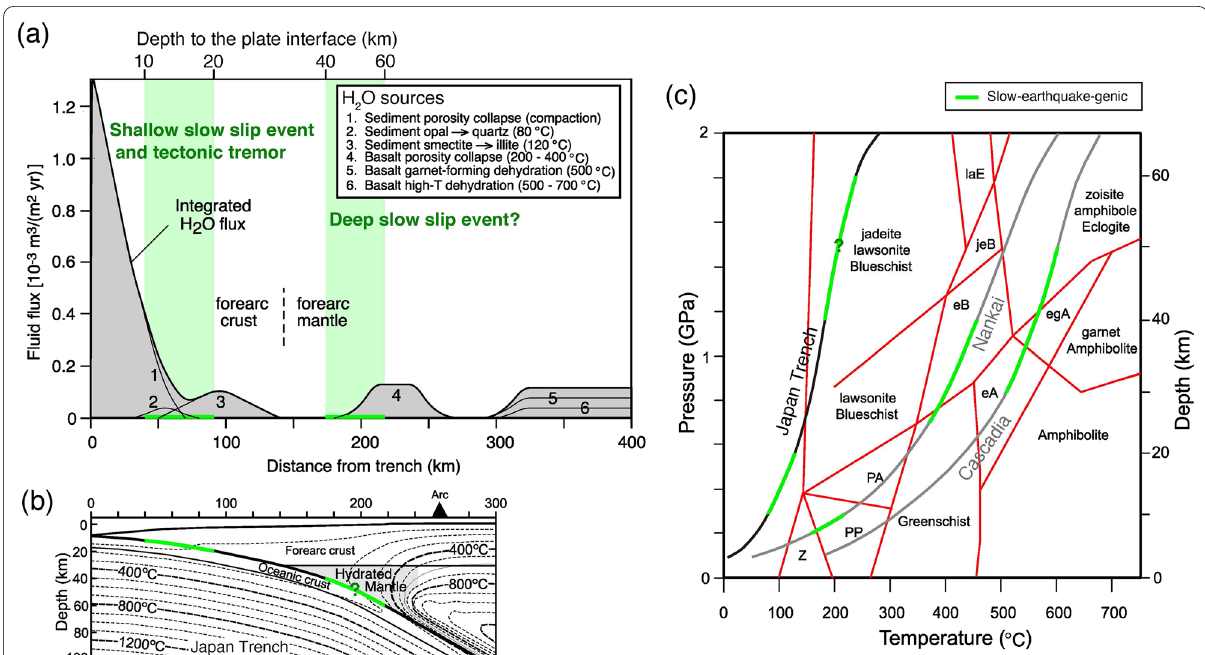
Fig. 13 Thermal and metamorphic environment of the Japan Trench. a Amount of water released upward from subducted sediments and the oceanic crust as estimated by Hyndman and Peacock (2003). For the details of the fluid flux estimation, see Hyndman and Peacock (2003). The green areas indicate the locations of the slow-earthquake-genic regions. b Thermal structure of the Japan Trench as estimated by Peacock and Wang (1999). This panel is adapted from Hyndman and Peacock (2003). The green sections of the plate interface indicate the locations of the slow-earthquake-genic regions. The question mark indicates the possible deep slow-earthquake-genic region. c Pressure–temperature paths for the top of the subducting oceanic crust in the Japan Trench, Nankai Trough, and Cascadia subduction zone (Peacock and Wang 1999; Peacock 2009). The pressure–temperature ranges of the slow-earthquake-genic regions are shown by the green sections of the pressure–temperature paths. The question mark indicates the possible deep slow-earthquake-genic region in the Japan Trench. Metamorphic conditions of the subducting oceanic crust (Peacock 2009) are also shown. eA, epidote–amphibolite; eB, epidote–blueschist; egA, epidote–garnet–amphibolite; jeB, jadeite– epidote–blueschist; laE, lawsonite–amphibole eclogite, PA; prehnite–actinolite; PP, prehnite–pumpellyite; and Z, zeolite